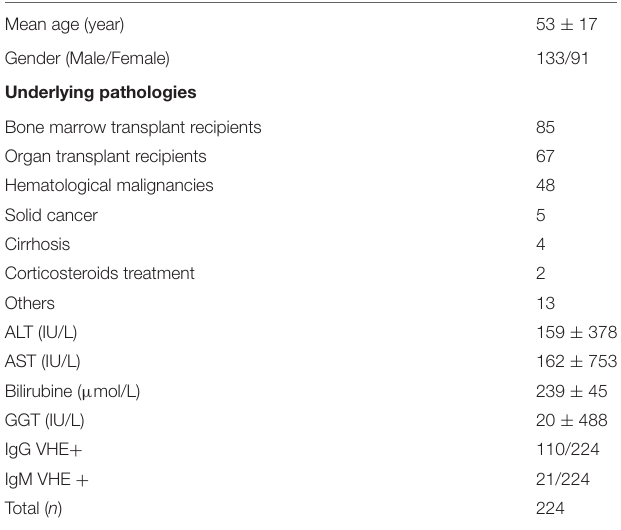
TABLE 1 | Clinical and demographic features of